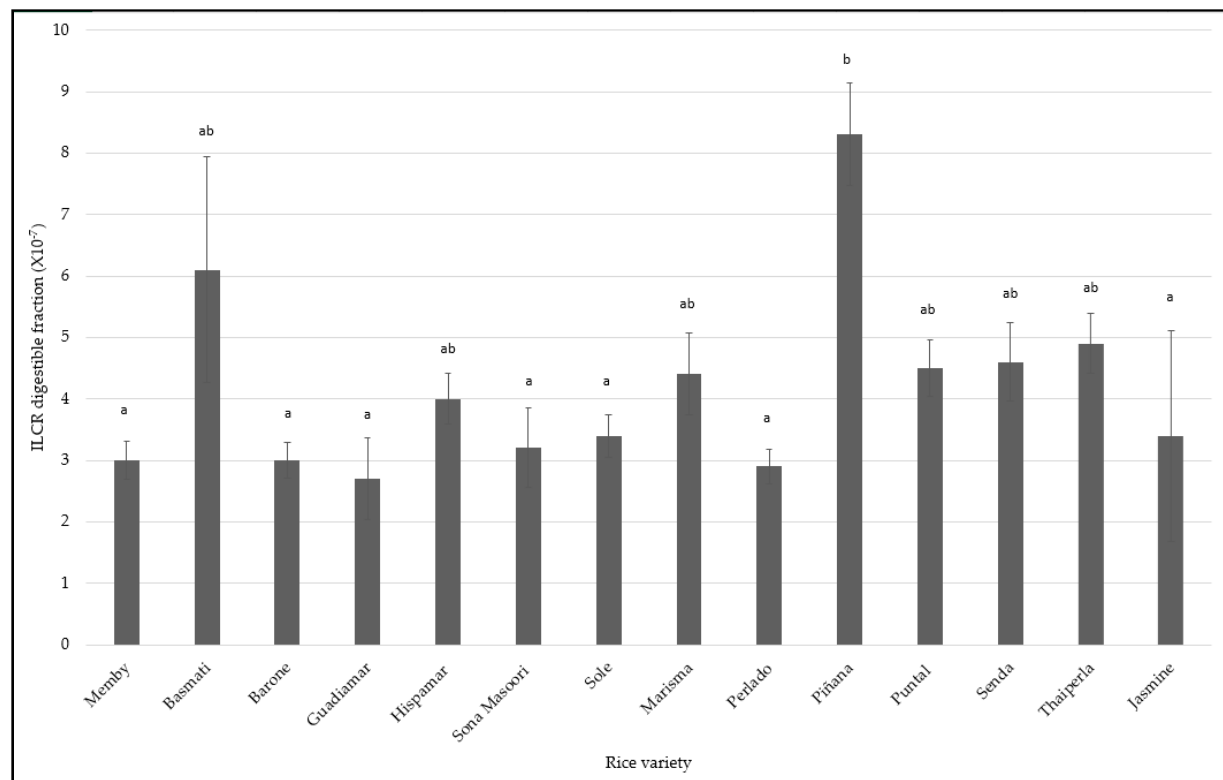
Figure 5. ILCR estimated of digestible fraction. Different letters in the same row indicate significant differences by ANOVA test ( p < 0.05).